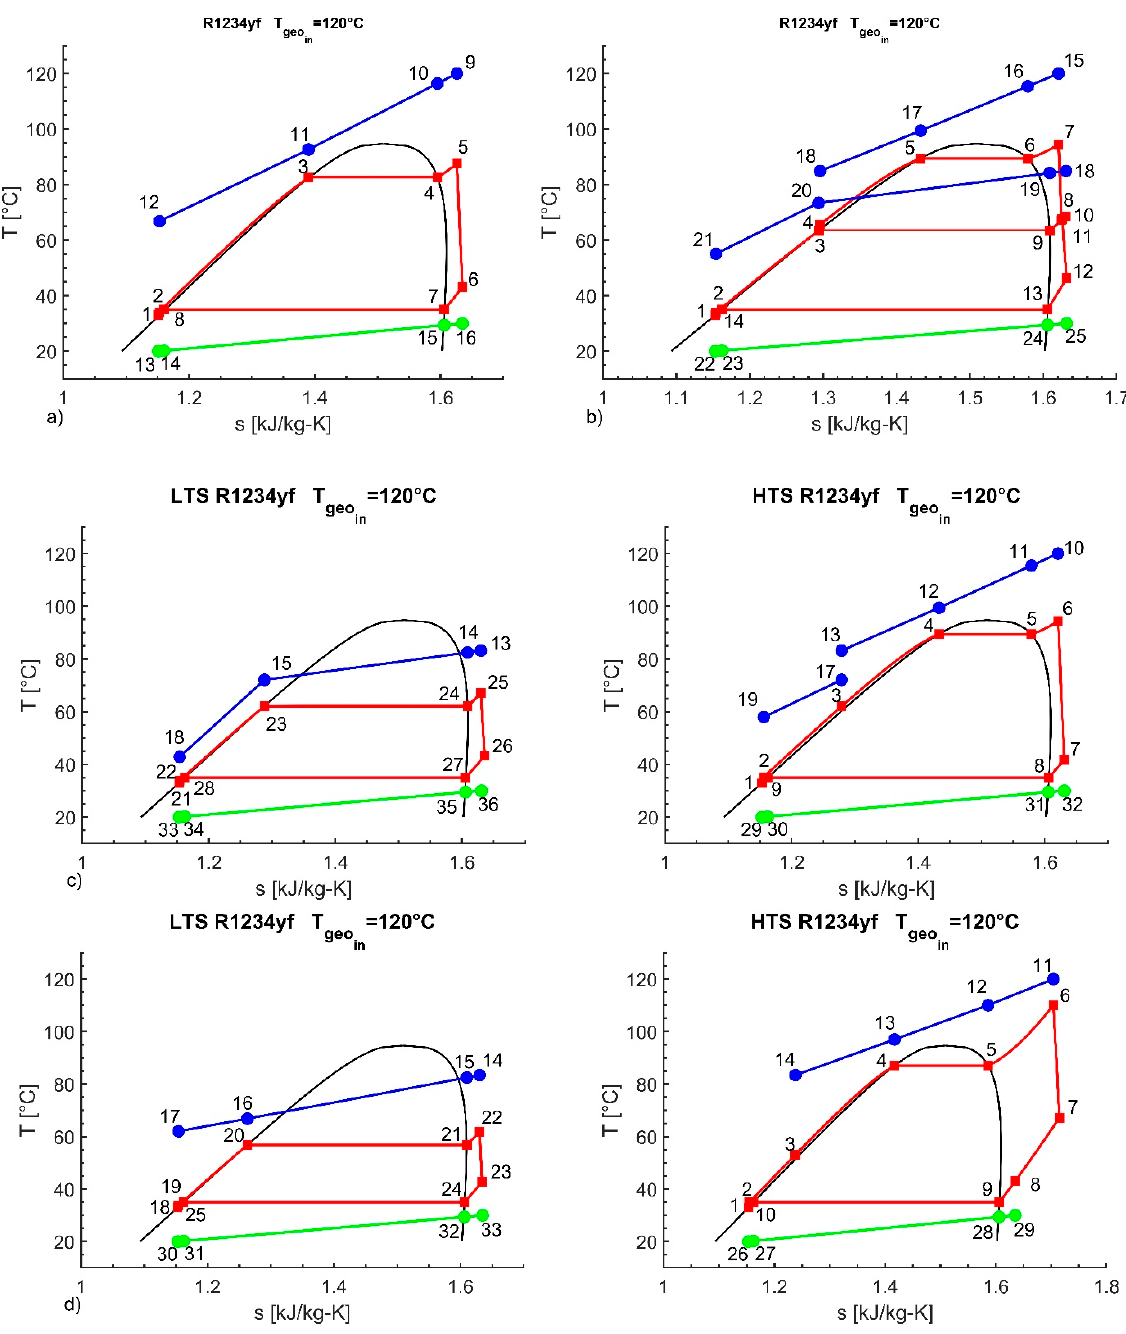
Figure 2. Ts diagrams of analyzed ORC configurations: ( a ) SORC; ( b ) DP ORC; ( c ) DS parHTS LTPH ORC; ( d ) DS HTSIHE ORC.